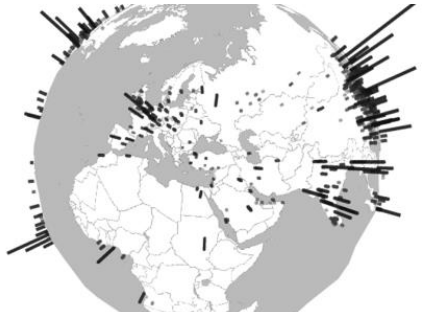
Figure 11. Interactive map of Mc Kinsey report 2011.